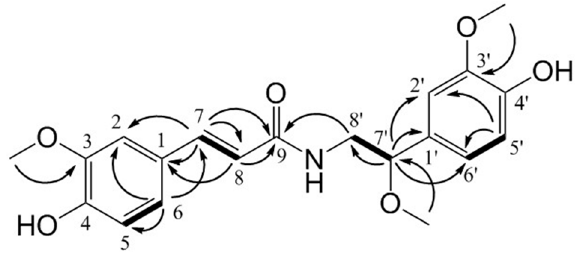
Figure 2. Selected key HMBC (plain arrow) and 1 H- 1 H COSY (bold line) correlations for 8 . Table 1. Spectroscopic data for compound 8 a in methanol- d 4.